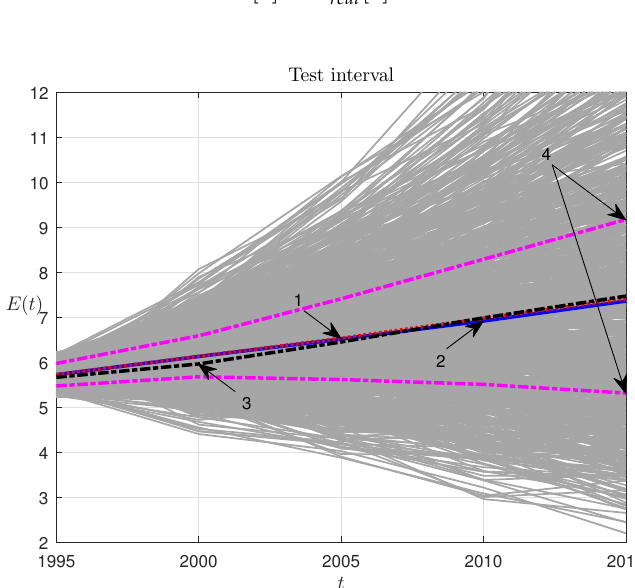
Figure 3. The ensemble of projection trajectories on the testing